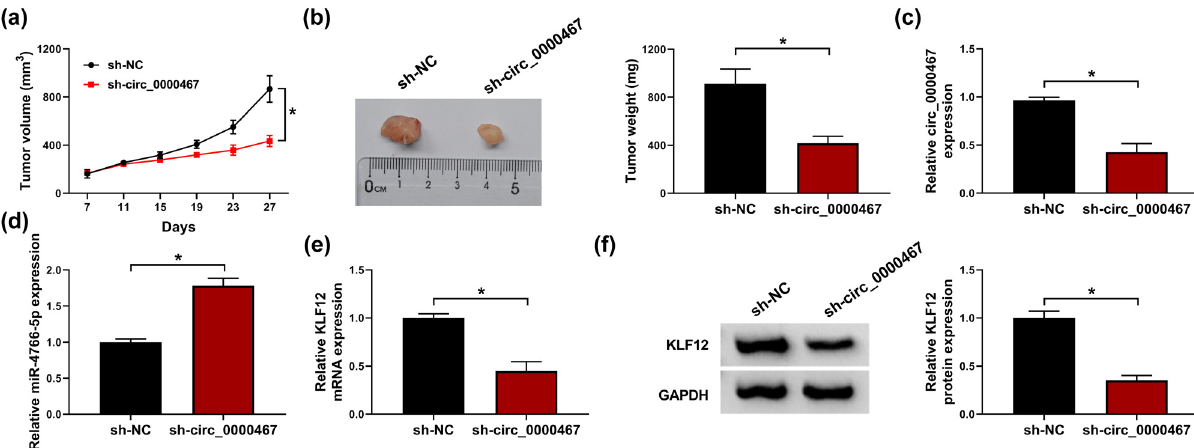
Figure 8: circ_0000467 downregulation retarded tumorigenesis of CRC in vivo via the miR - 4766 - 5p/KLF12 axis. ( a ) Tumor volume of sh - NC or sh - circ_0000467 group was measured every 4 days after cell inoculation for 1 week. ( b ) Tumor tissues were weighed on an electronic scale. ( c and d ) The RT - qPCR was conducted to examine the expression of circ_0000467 and miR - 4766 - 5p in tissues. ( e and f ) KLF12 mRNA ( e ) and protein ( f ) levels were tested using RT - qPCR and WB. * P <